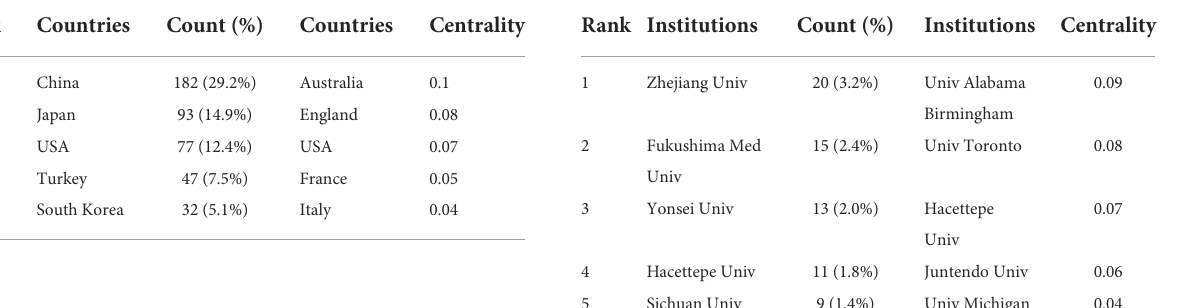
TABLE 1 The top 5 most publication